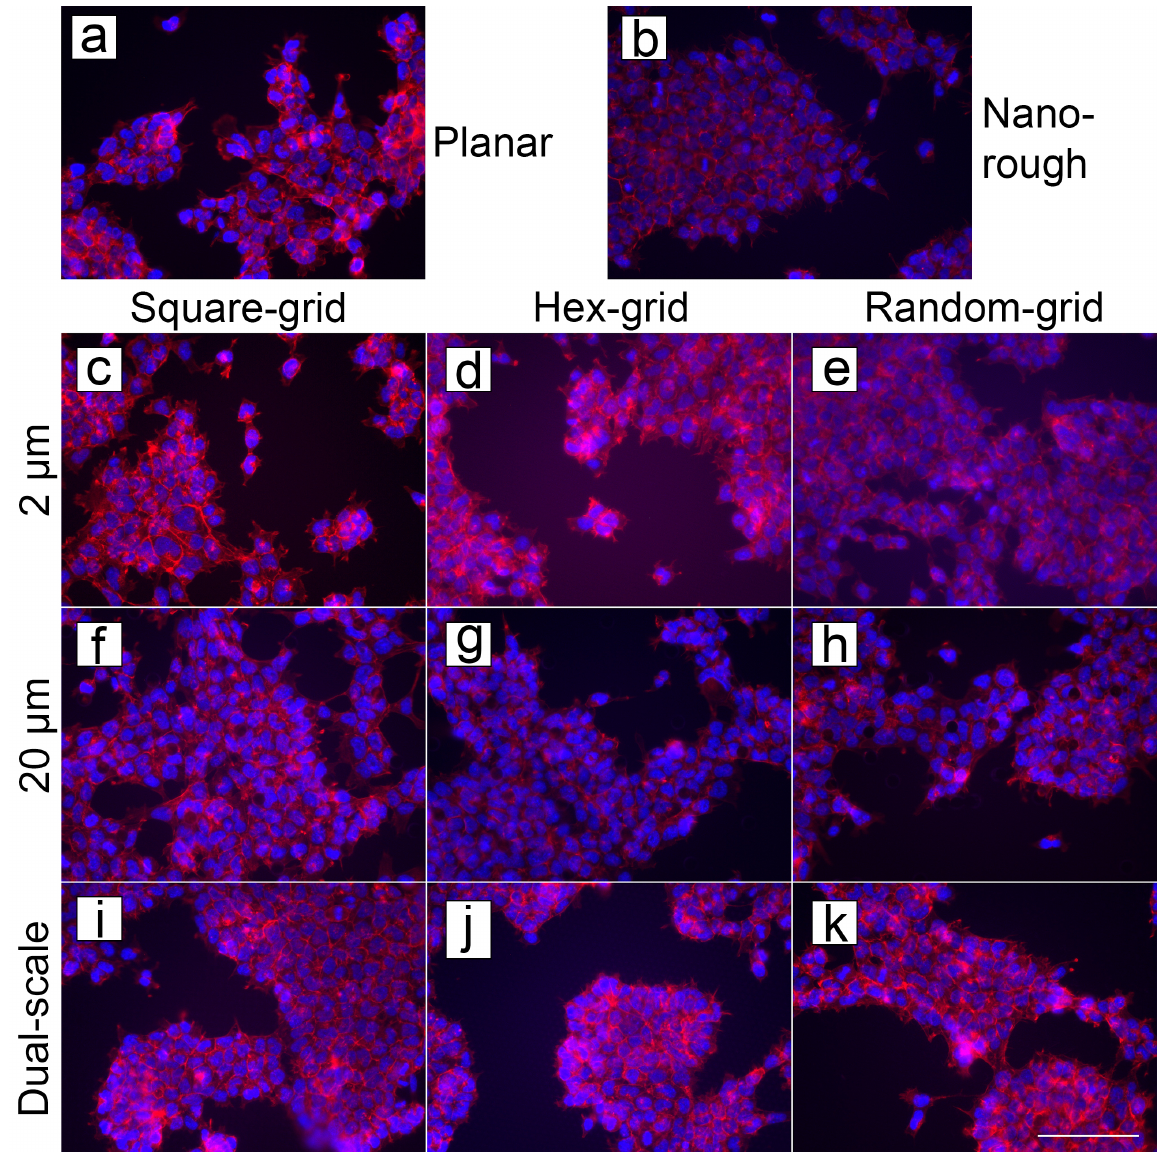
Figure 9. Stained mNSC on PyC structures. Cells on ( a ) planar PyC substrate (reference), ( b )